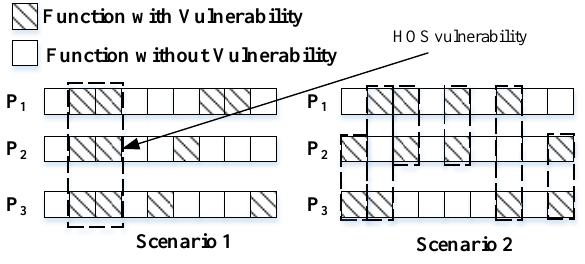
Figure 5. Schematic diagram of high-order symbiosis of vulnerabilities.